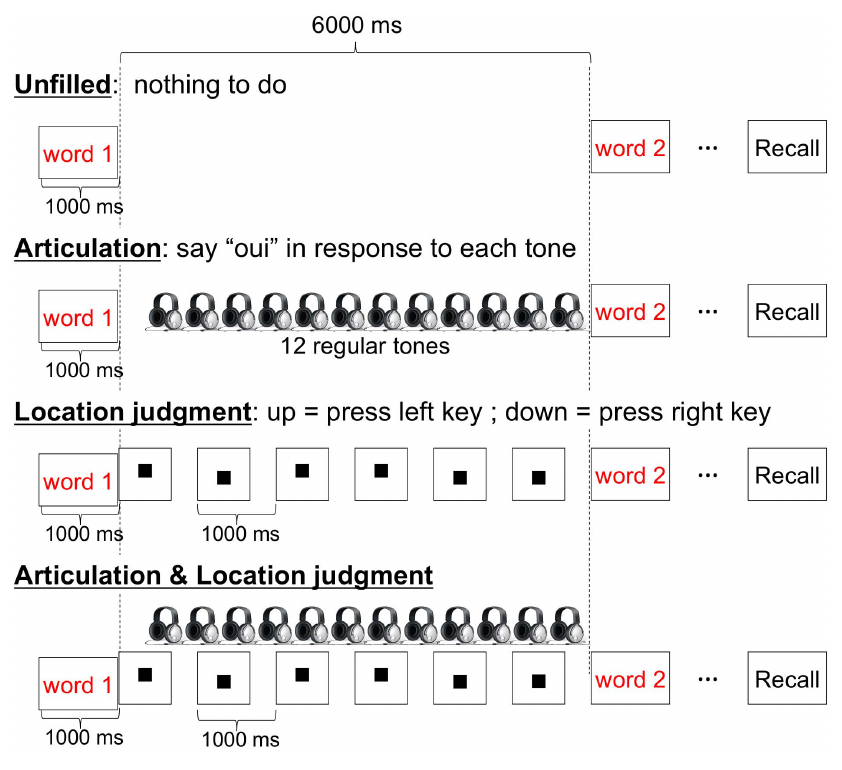
Figure 1. Illustration of the four conditions.